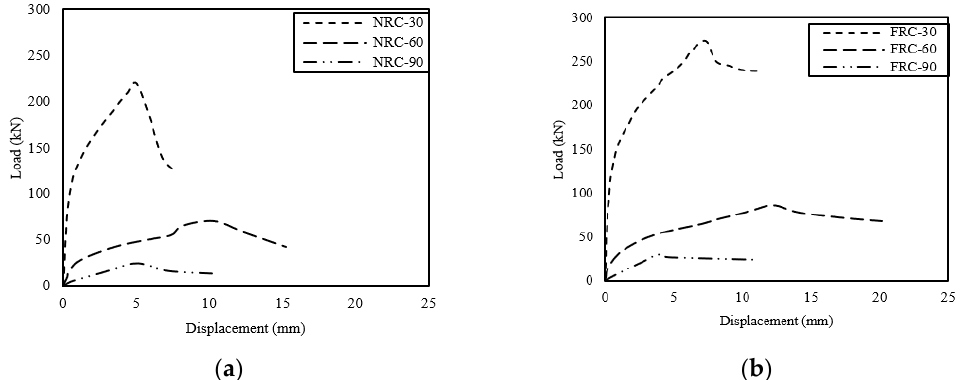
Figure 15. Load – vertical deflection comparison between V-shaped columns of ( a ) NSC and ( b ) FRC specimens.